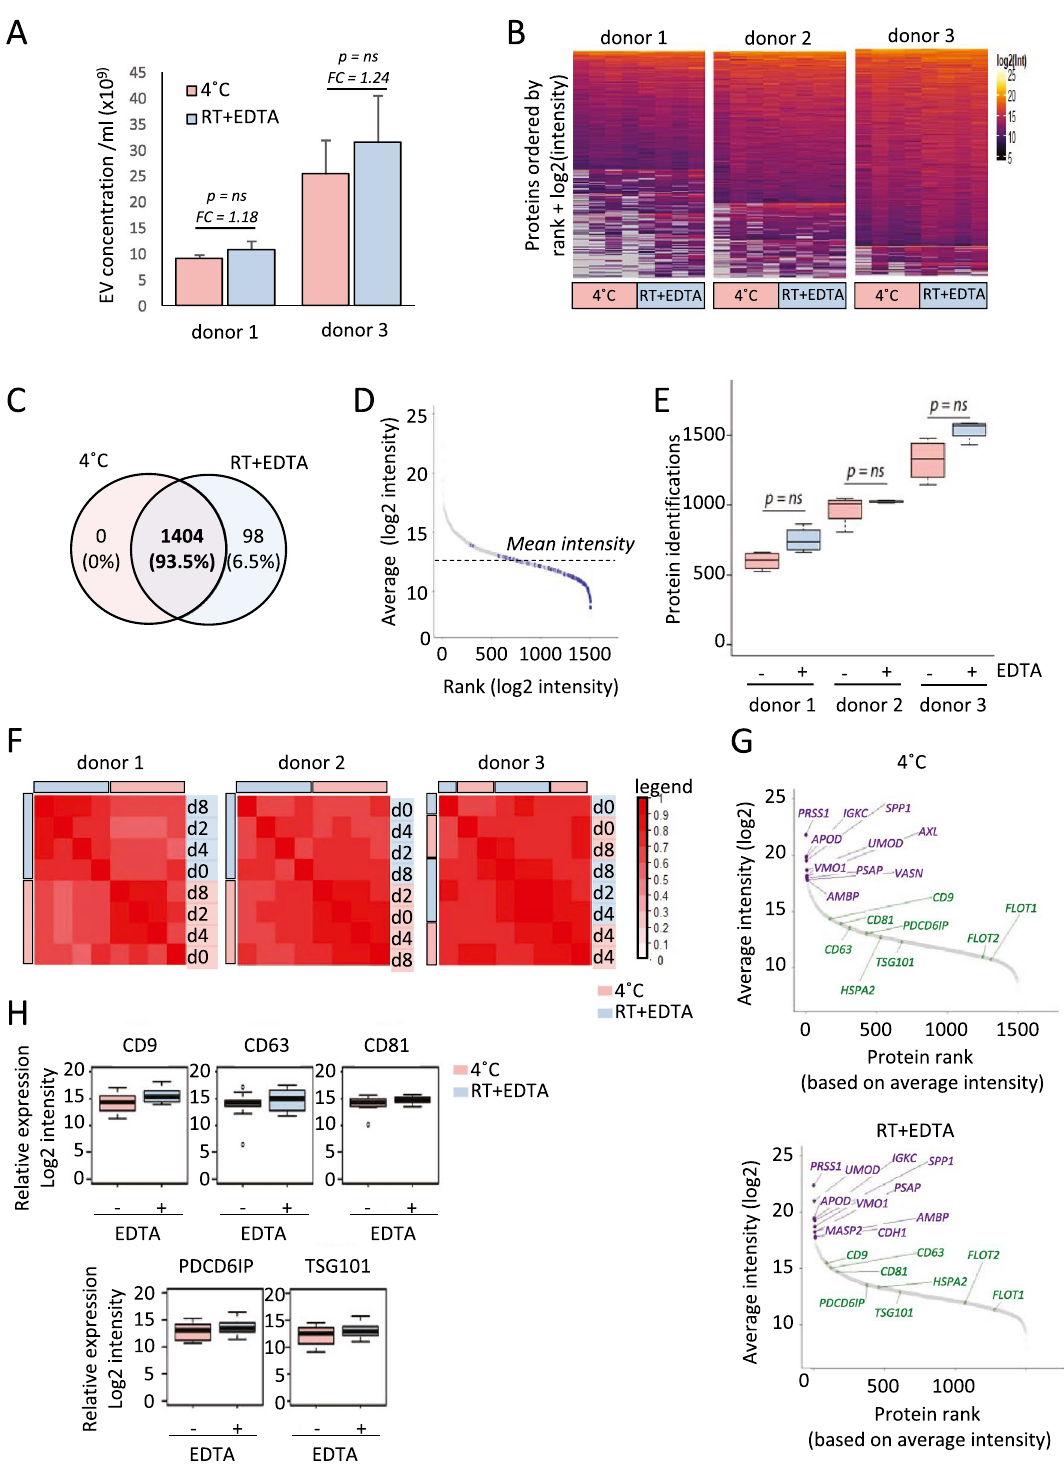
Figure 4. Effect of EDTA on urinary EV proteins. ( A ) Effect of EDTA on the concentration of EVs as measured using the EVQuant assay. ( B ) Data presence plot, showing a high data presence amongst all samples. The proteins were ranked according to data presence and average log2-intensity. The missing values are gray. ( C ) Venn diagram showing the number of proteins identified in urine samples stored at 4 °C vs EDTA. ( D ) Protein rank plot showing that the 98 unique proteins identified upon addition of EDTA (indicated in blue) are low abundant. ( E ) Number of proteins identified in the three donors with and without EDTA addition, showing no significant difference between the three donors. ( F ) Pierson correlation plot showing a high correlation between all urine samples. Blue bars are samples where EDTA is added, pink bars indicate the samples stored at 4 °C. ( G ) Protein rank plot showing that the proteins identified and EV markers are highly consistent. ( H ) Boxplots of known EV markers showing no difference in abundancy between the two storage